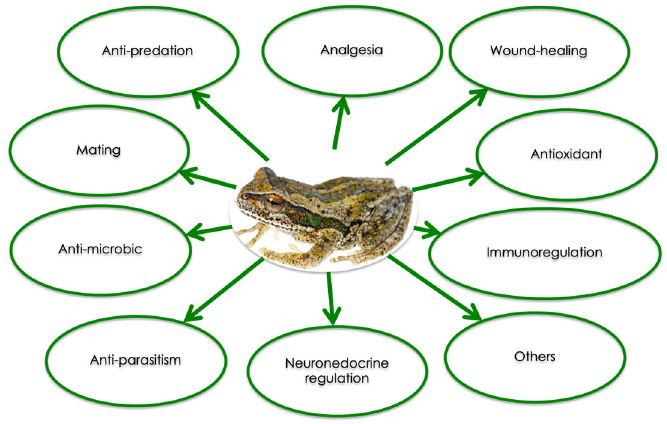
Figure 2. Summary of the biological activities of amphibian skin peptides (Modified from [9]).